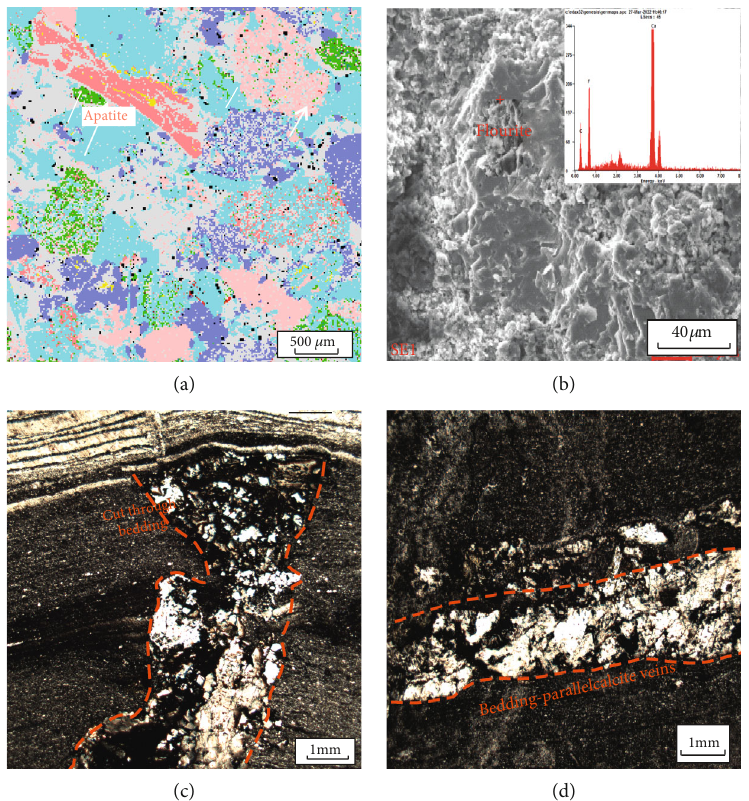
Figure 14: Characteristics of magmatic-hydrothermal mineral composition in Lucaogou Formation, Jimsar